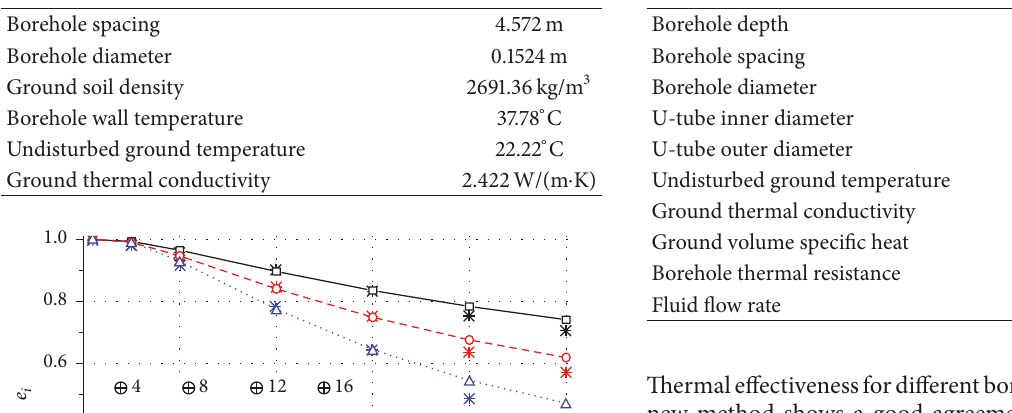
Table 1: Simulation input data [19].